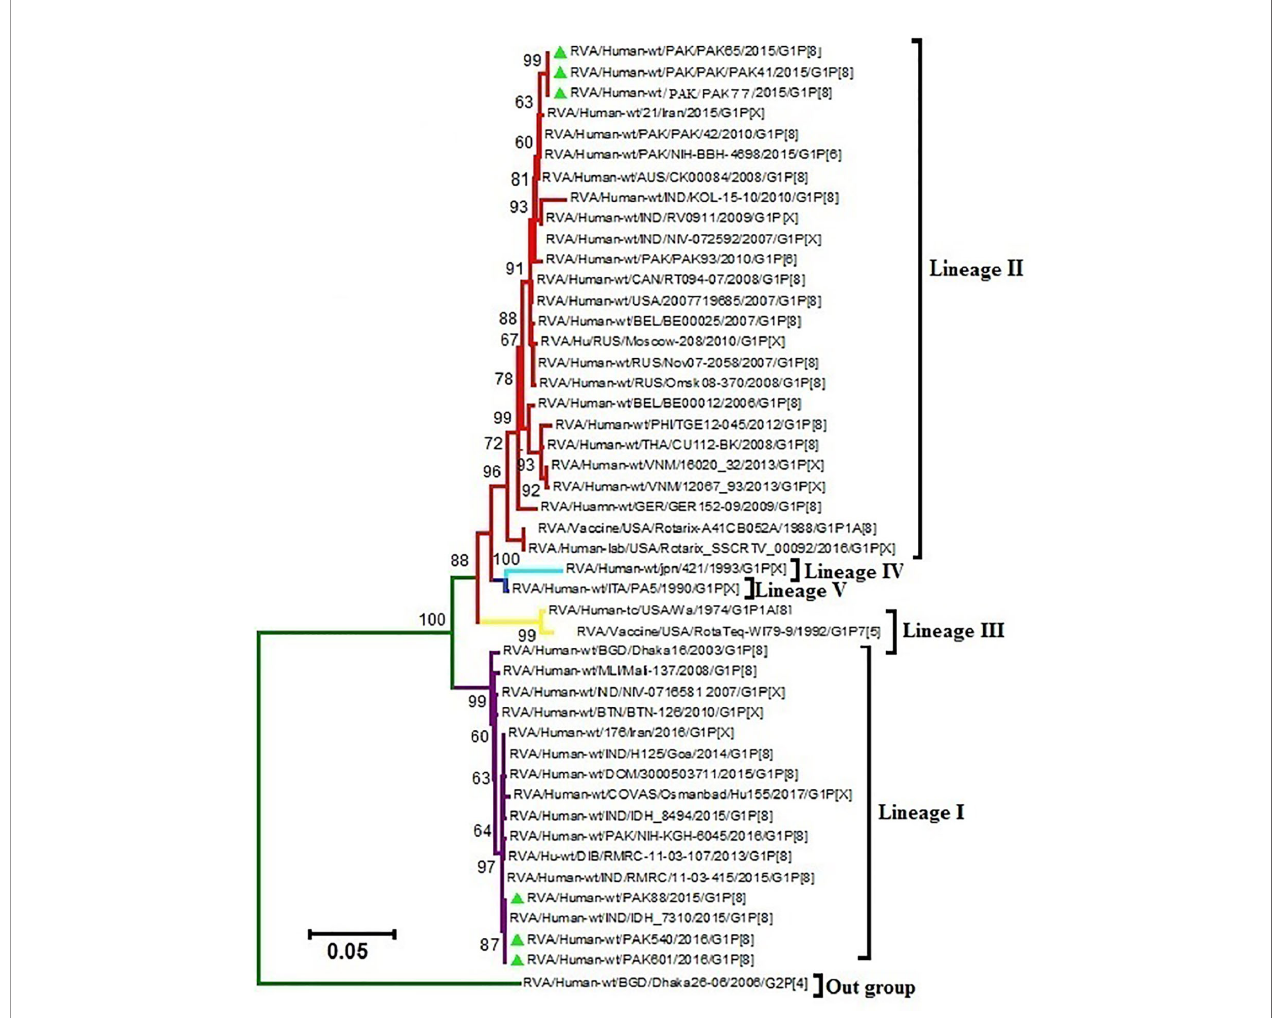
FIGURE 2 | Maximum Likelihood tree of the VP7 protein of G1P[8] group A rotavirus (RVA) strains reported in Pakistan and the vaccine strains Rotarix ™ and RotaTeq ™ . Maximum Likelihood trees were generated using Kimura-2-parameter model in MEGA 6. Coloured branches represent different lineages. The lineage I is represented by purple colour branch including strains isolated from all over the world and our study strains represented by green triangles in the same branch. The lineage II is represented by red colour branch including strains isolated from all over the world and our study strains represented by green triangle in the same branch. Yellow colour branch includes strains belong to lineage III. Aqua colour branch includes strains belong to lineage IV. Blue colour branch includes strains belong to lineage V. G2P[4] RVA strain from Bangladesh is used as an out-group represented by green colour branch. Bootstrap replicates (1000) below than 60% are not shown in the